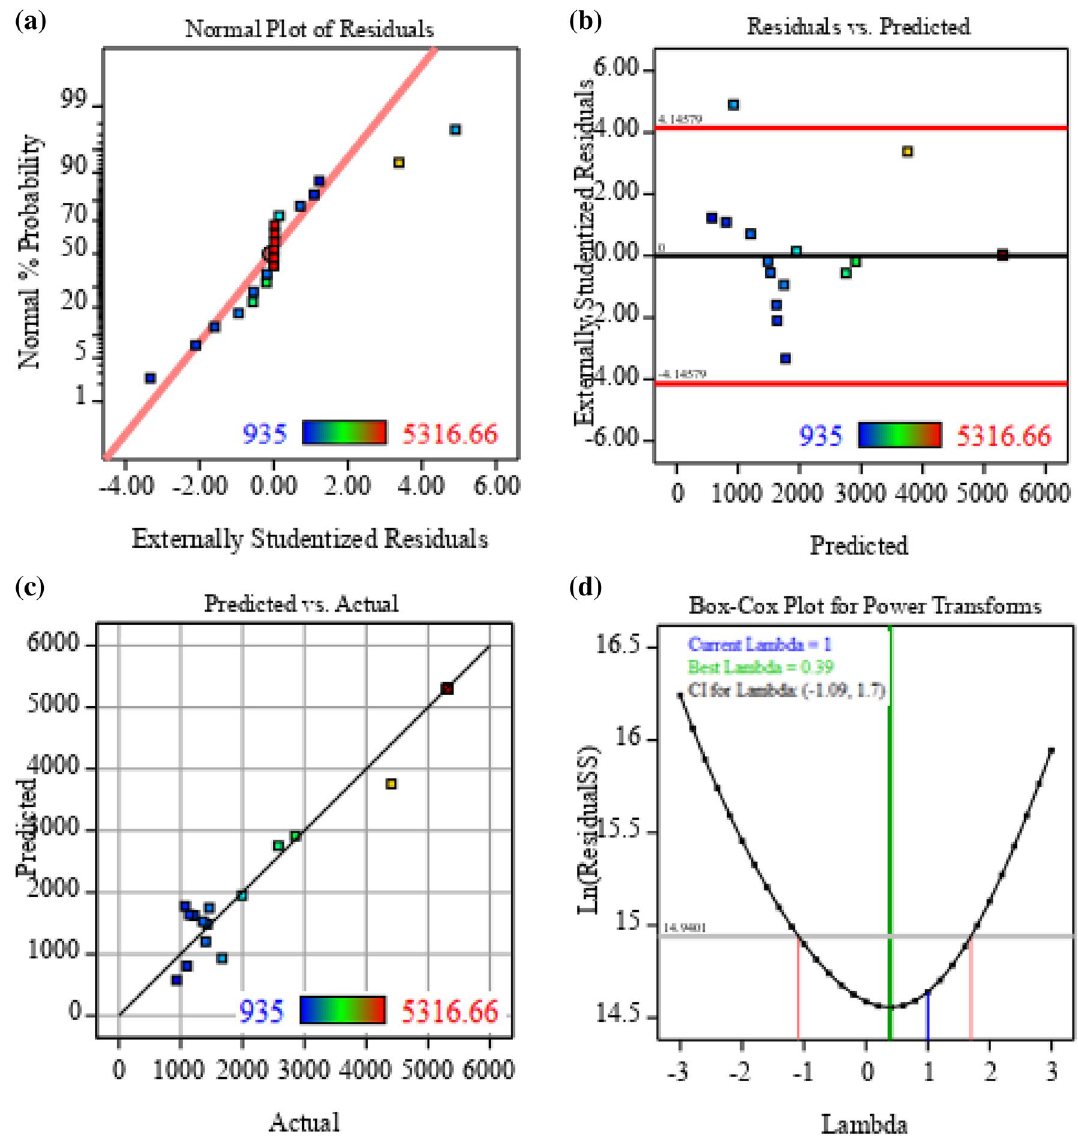
Figure 4. Model adequacy checking of CCD-uniform precision: (a) normal probability plot of the residuals, (b) externally studentized residuals versus predicted ALP production, (c) plot of predicted versus actual ALP production, and (d) Box-Cox plot of model